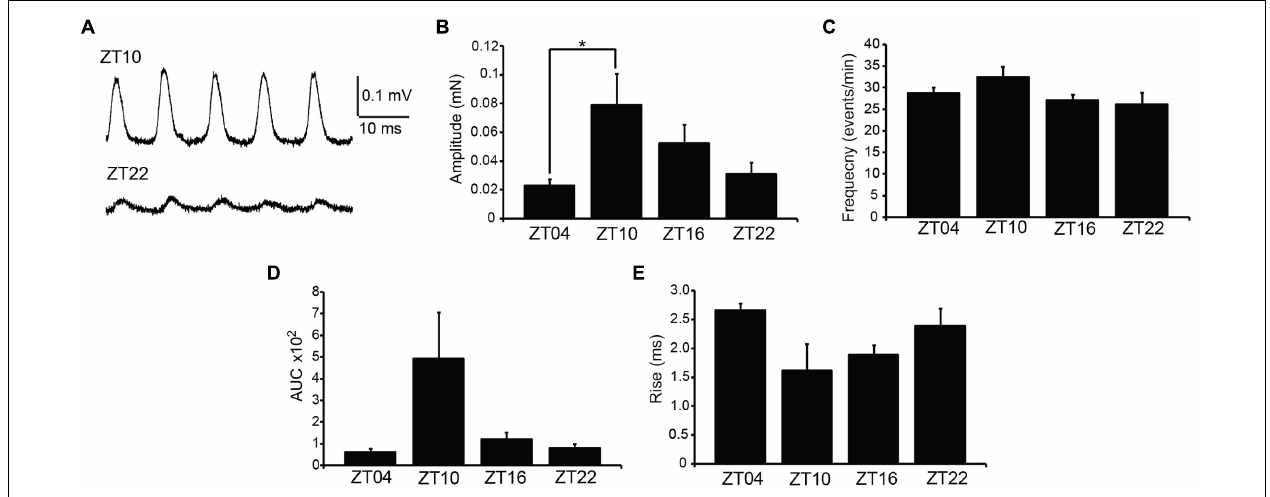
FIGURE 2 | Spontaneous (phasic) contractions are larger at ZT10. (A) Representative phasic contractile activity at ZT10 and ZT22. (B) Phasic amplitude differs by time of day. p = 0.03 (one-way ANOVA), *Bonferroni post hoc , p < 0.04. (C) Phasic frequency is not